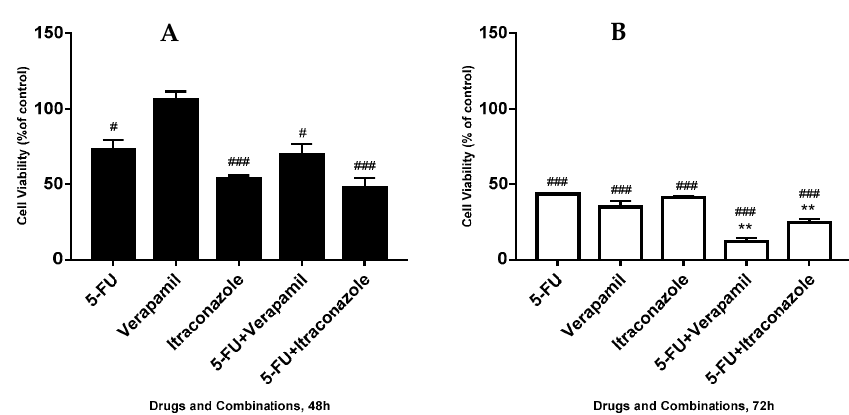
Figure 8. Effect of 5-FU, verapamil, itraconazole, and respective combinations of the last two drugs with 5-FU on the viability of MCF-7 cells, for 48 h ( A ), 72 h ( B ) and a comparison of both times ( C ). Each drug and drug combination were added in fresh medium, in sextaplicates. Results are presented as mean ± SEM, and represent the viability of cells (% of control) of 3–4 independent experiments. ### p < 0.001 and # p < 0.05 vs. control; ** p < 0.01 vs. single drug of the combination with more effect on cell viability reduction .